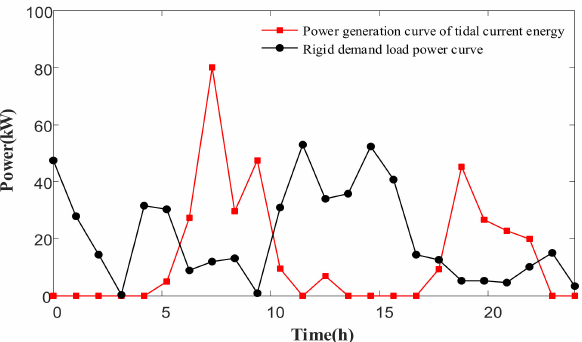
Figure 7. A 24-h curve of the day-ahead tidal current energy generation output and island load.